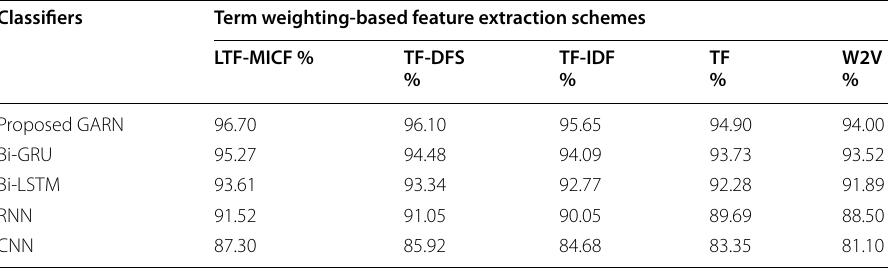
Table 6 F-measure of the proposed and existing classifiers with term weights